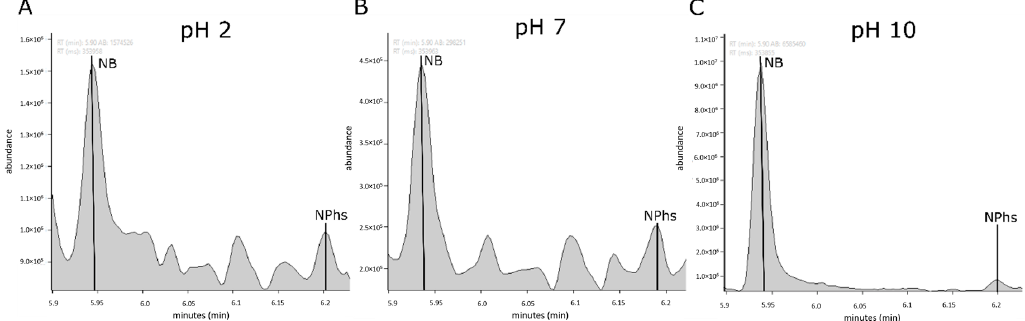
Figure 8. Gas chromatography (GC) chromatograms of the NB photocatalysis extracts for the reactions at pH: ( A ) 2, ( B ) 7 and ( C ) 10. The two peaks were detected to be NB and reaction intermediaries, nitrophenols (NPhs).